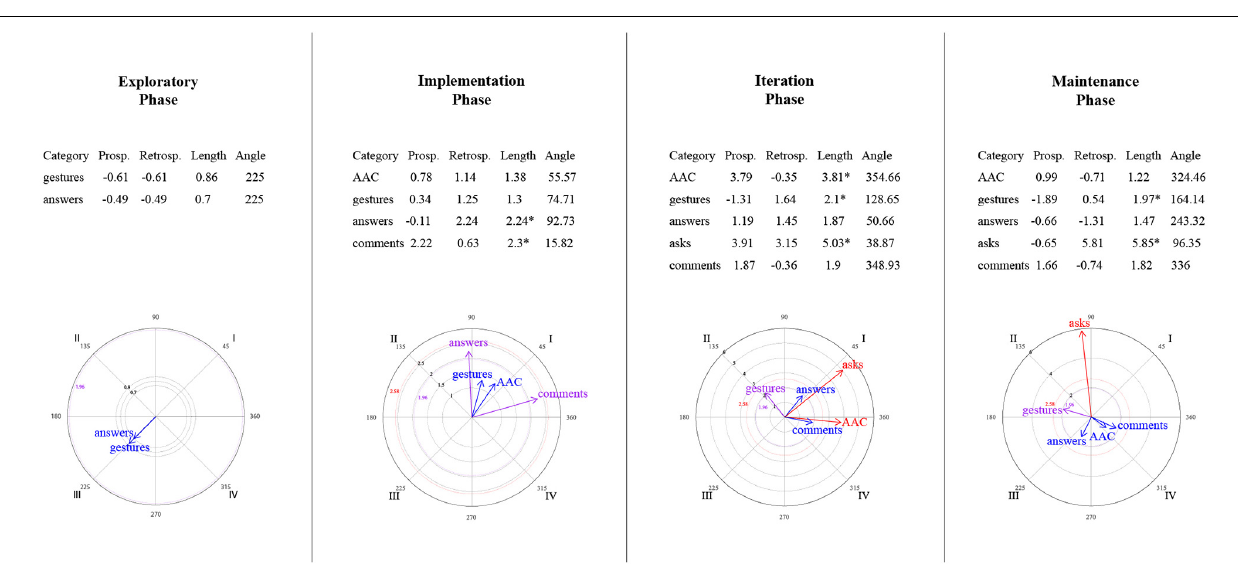
FIGURE 11 | Vectors corresponding to the mother’s emotion-related comments as focal behavior, and the child’s emotion-related communicative turns [answers, comments, asks questions] and methods of expression [AAC, conventional gestures] as conditional